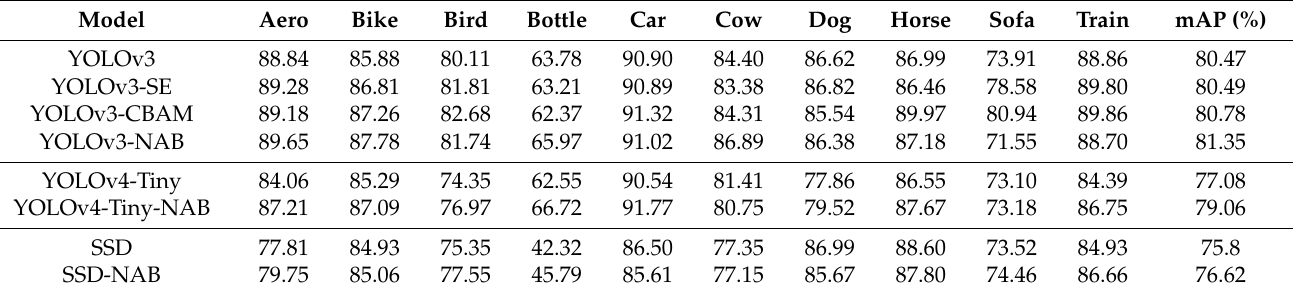
Table 4. Detection results on PASCAL VOC. We chose 10 categories at random to show the compar- isons of their AP (%). We retrained YOLOv3, YOLOv4-Tiny, and SSD for a fair comparison using the same configuration of the improved